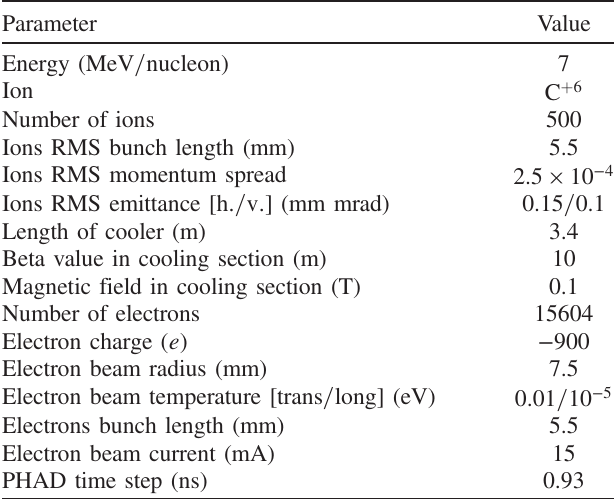
, and ϵ 6 of D D D